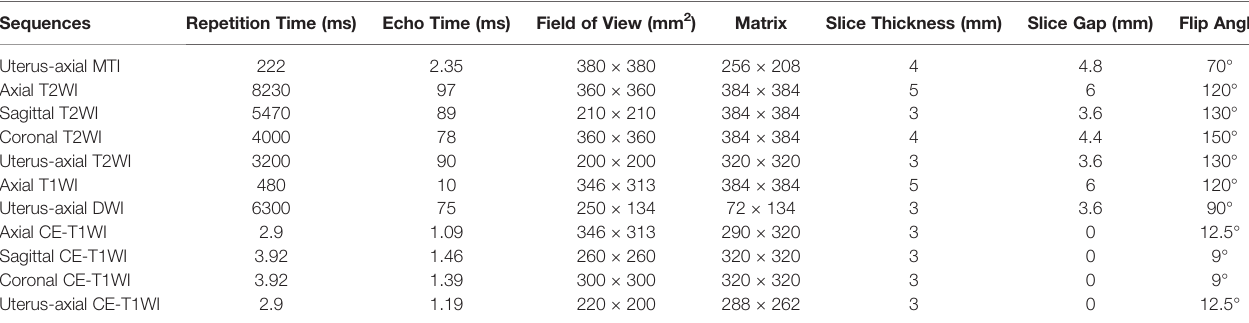
TABLE 1 | MR imaging parameter